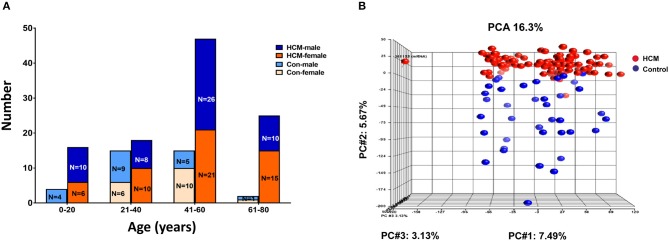
Microarray data from HCM patients undergoing myectomy compared to control (healthy organ donor) hearts. (A) Age and sex distribution of HCM patients and controls. (B) PCA plot represents the results of a principal component analysis of all samples' normalized log2 fluorescence values, wherein each dot represents a single sample, its color indicates HCM (red) or control (blue) status. Each of the plot's three dimensions separates the samples based on a subset of all the microarray's genes, selected by correlation. The X-axis gene set represents the highest percentage of overall variation, followed by Y and Z in that order. One HCM sample on the X-axis (far left) is an outlier and was excluded from normalization of the ANOVA signal values. The Y-axis depicts a good, albeit not perfect, separation of the two biological classes, which ANOVA defines as the genes that distinguish HCM hearts from control hearts.